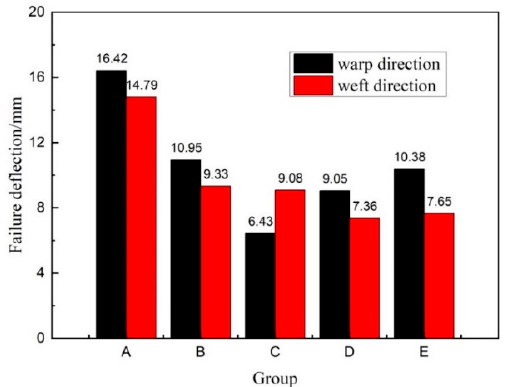
Figure 12. Failure deflection in warp and weft directions. For low core height samples, the upper and lower layers easily moved together and bore the effect of force, so the average failure deflection was high. For high core height samples, the upper and lower layers could not move together smoothly due to increased gap between the face sheets. Moreover, due to the flow of shear force in the core phase, the upper face sheet became the weak point. The force on the upper surface layer quickly reached the maximum, and fracture occurred due to contact with the loading head. The top face sheet generally bears the compressive load and the bottom face sheet bears the tensile load, while pile failure occurs due to the shear load [16,22,23]. Figure 13 shows the reverse view of damaged specimens in groups C and D. In the group C sample, there was apparent damage in both the top and bottom face sheets. The bottom face sheet fracture was more evident than the top face sheet fracture. However, in sample group D, the fracture was only seen in the bottom face sheet, with no apparent damage on the top face sheet. Due to the thickness of the top face sheet being higher than that of the bottom face sheet, the bottom face sheet was damaged first and the fracture was obvious. This observation clarifies that the thickness of the face sheet has a significant influence on the bending performance of the material. Different studies have shown that the bending load resistance of 3D integrated woven spacer composites can be improved using thickened face sheet. Complex-shaped face sheets have better performance than plain-shaped face sheets and experience minor damage on the bottom face sheet [9,24]. To observe the core pile damage phenomenon and visualize microstructural details of the bending, XR-CT test was conducted on the specimens. The core pile fracture and cross- sectional view of the group E sample can be seen in Figure 14. The XR-CT image showed the damage behavior of reinforced 3D integrated woven spacer fabric without the matrix material. The core pile yarn fracture and the yarn bending phenomenon were seen in the cross-sectional view of both the warp and weft directions. The internal torn fibers were attached to the resin matrix and looked undamaged in the specimen due to the resin ma- trix, but they were internally damaged and isolated, which was apparent in the XR-CT image.